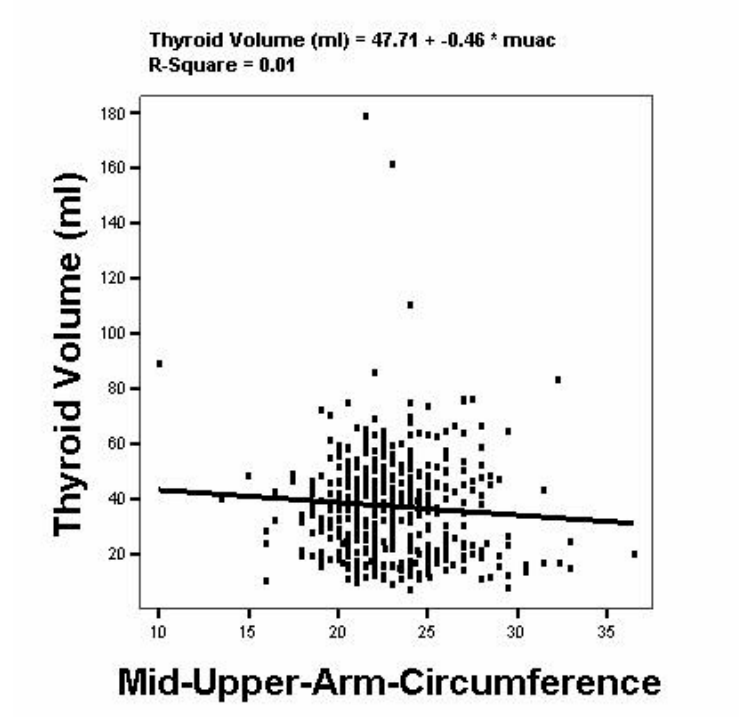
FIGURE 3. Linear regression